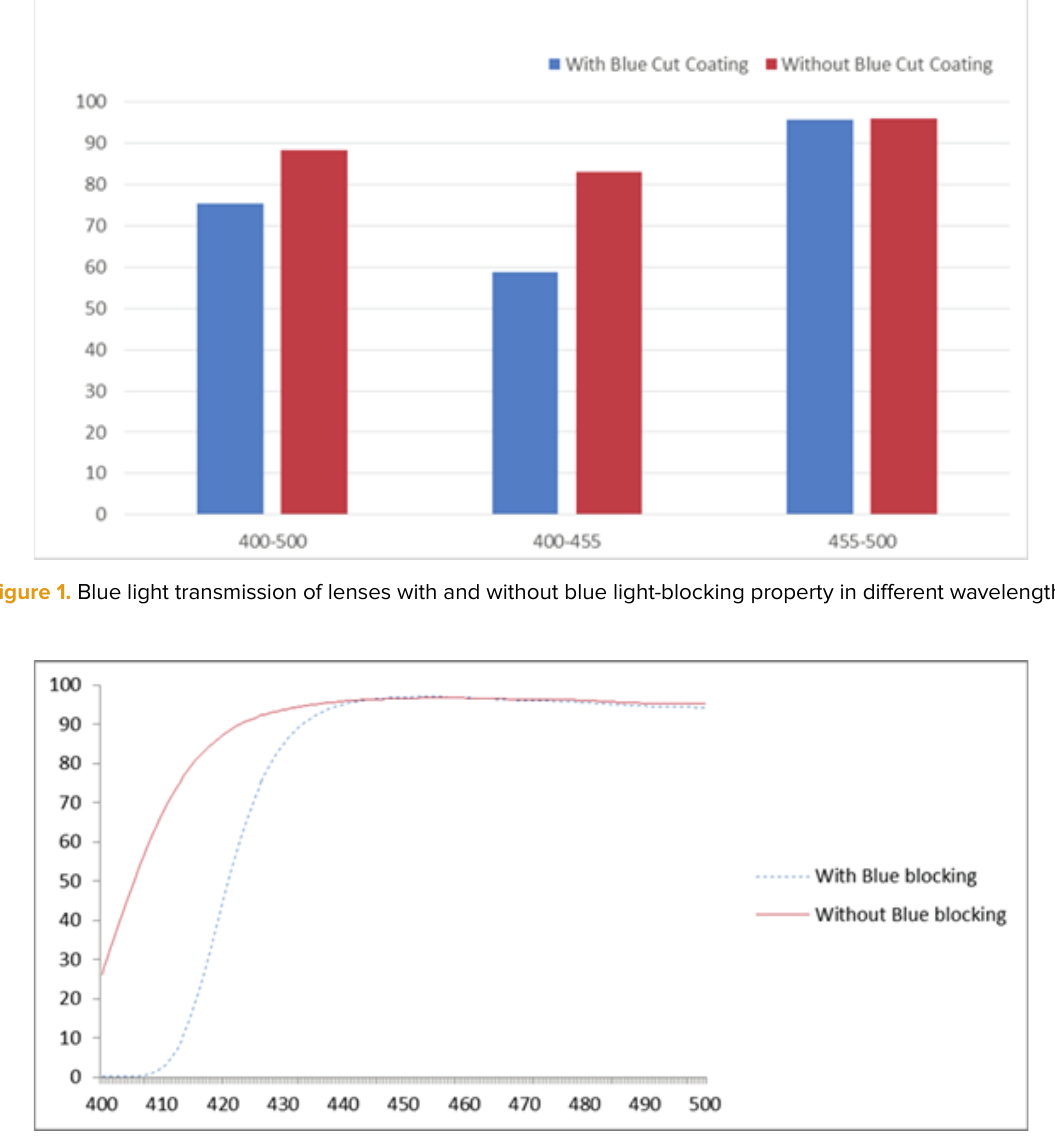
Figure 2. Comparison between spectral transmittance of lenses with and without blue light-blocking